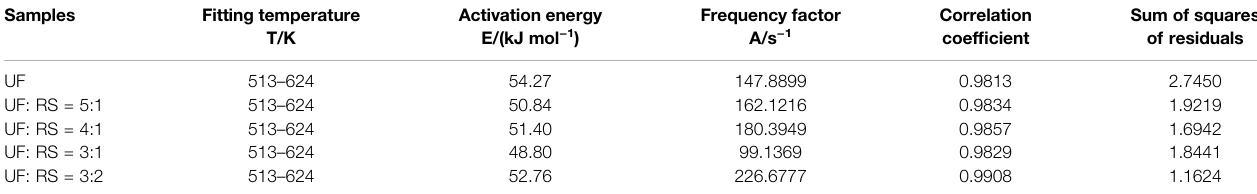
TABLE 1 | Kinetic parameters of pyrolysis reaction of fi ve different samples. Samples